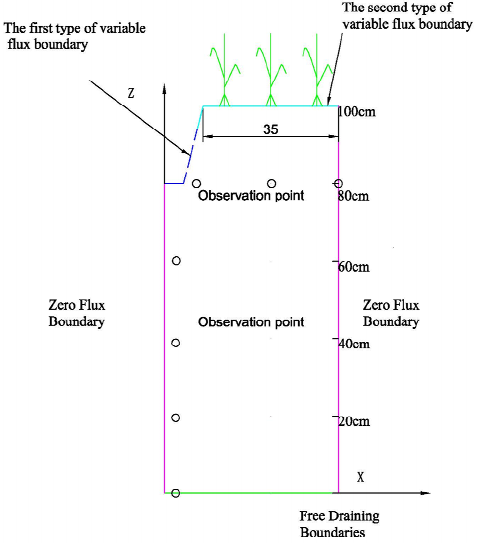
Figure 3. Boundaries of soil water and nitrogen transport model.